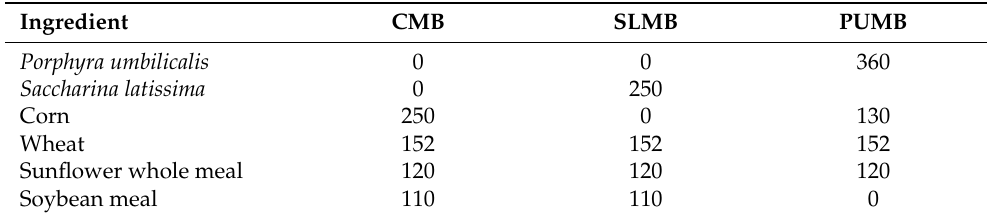
Table 1. Ingredient composition (g/kg fresh matter) of multinutrient blocks including no seaweed